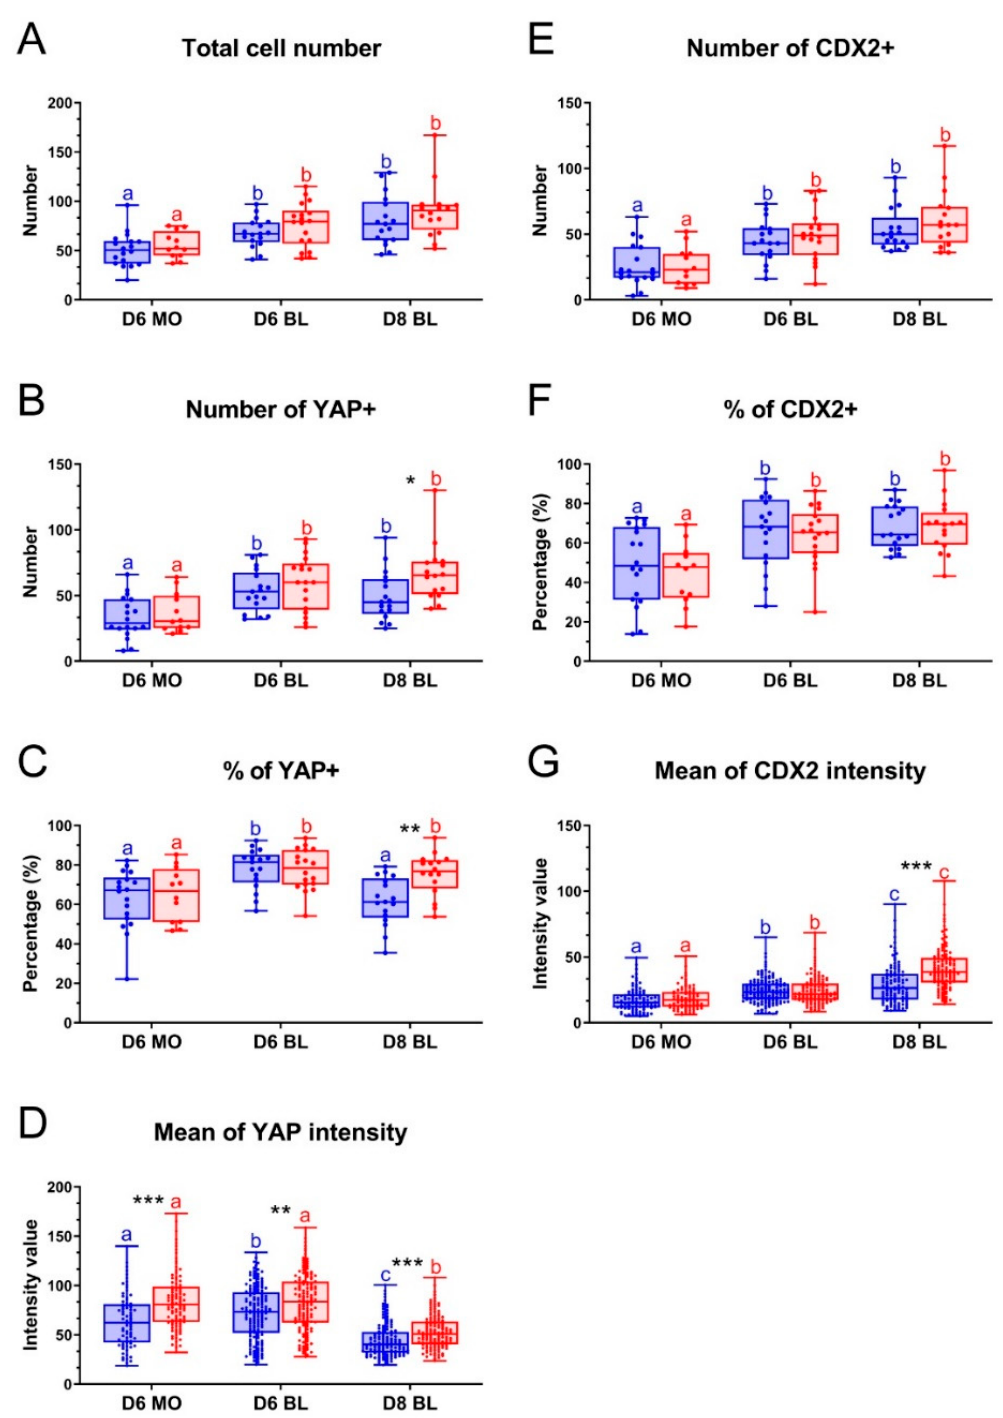
Figure 4. Effect of LPA on YAP and CDX2 expression in bovine embryos. Embryos were cultured in the absence of LPA (blue) or in the presence of 10 − 5 M LPA (red). Total cell number ( A ), number of YAP positive cells ( B ), percentage of YAP positives out of total cell population ( C ), Mean YAP intensity (RFU) in single nuclei ( D ), number of CDX2 positive cells ( E ), percentage of CDX2 positives of total cell population ( F ), Mean CDX2 intensity (RFU) in single nuclei ( G ). * ( p < 0.05), ** ( p < 0.01) and *** ( p < 0.005) indicate significant differences between embryos cultured with and without LPA. Significant differences among embryos cultured under the same conditions are indicated by different letters with the same color ( p < 0.05). Error bars indicate standard deviations of embryos or single cells, collected from three biological replicates. D = day, MO = morula, BL =